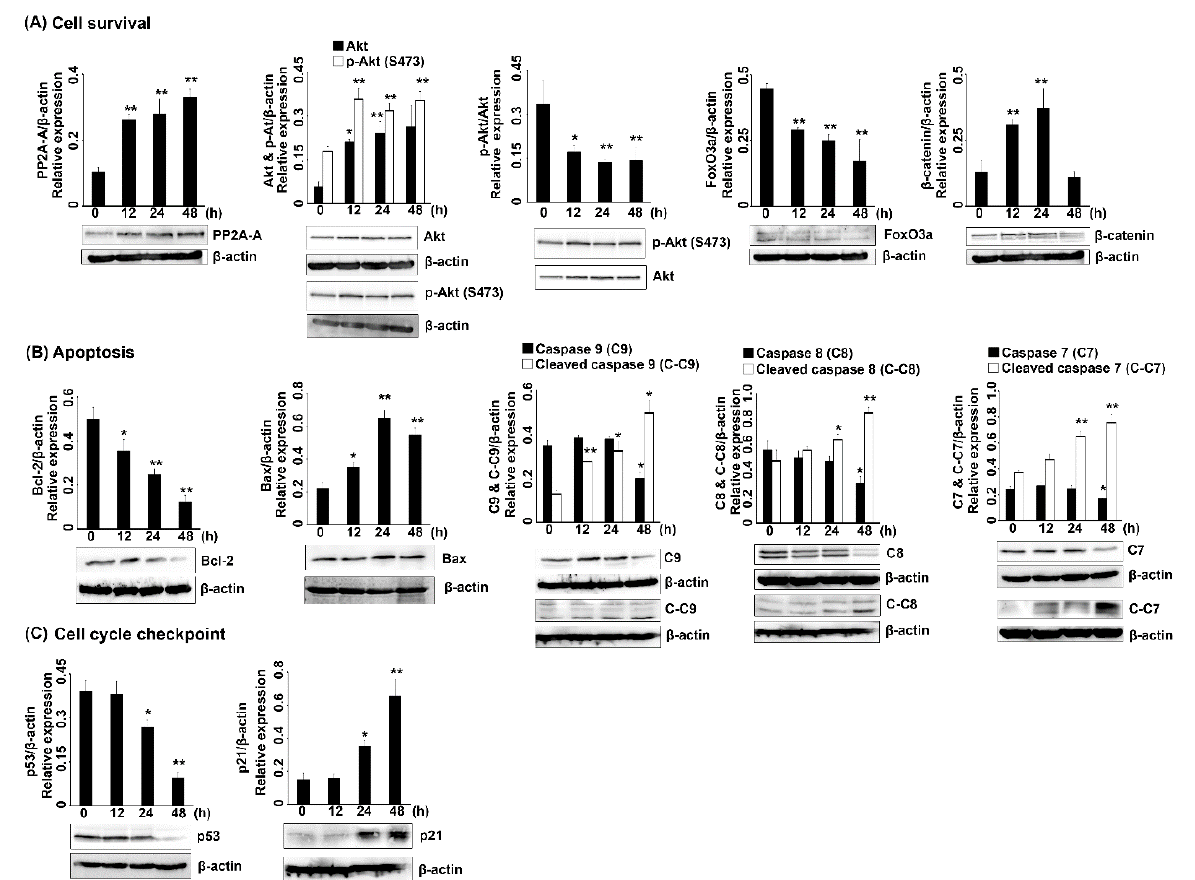
Figure 5. Protein expression in triple-negative breast cancer cells treated with 6 µM 7HF for 0, 12, 24 and 48 h . ( A – C ) The expression of cell survival-related, apoptotic and cell cycle checkpoint proteins and their relative expression, respectively. C-7, C-8 and C-9: caspase-7, 8 and 9; C-C7, C-C8 and C-C9: cleaved caspase-7, 8 and 9. Data represent mean values from three independent experiments. The relative protein expression was statistically analyzed using one-way ANOVA and Tukey’s HSD multiple comparisons test (* p < 0.05, ** p <